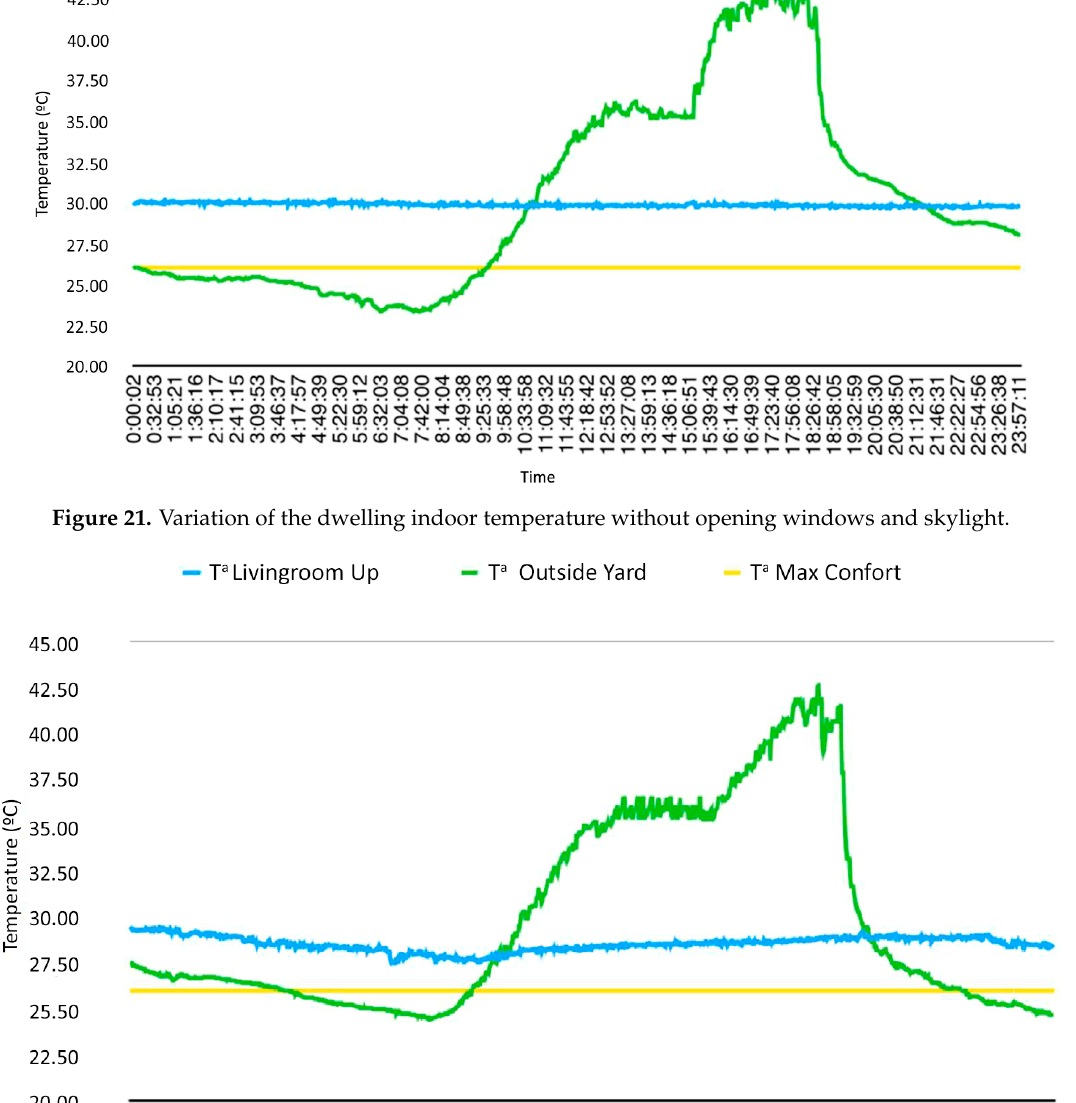
Figure 23. Daily variation in the outside air temperature and the output of the LEGE system for August 4, 2015. Renewable Electric Energy Production Figure 24 shows the electric production curve of the photovoltaic facility (the ocher line) on 10 July 2015. Since it is a summer month, air conditioning in the home is active. The gray line represents the value of 575 W, corresponding to the approximate consumption of one of the split-type air conditioning units assembled as part of the HVAC system. Note that, in the hours of